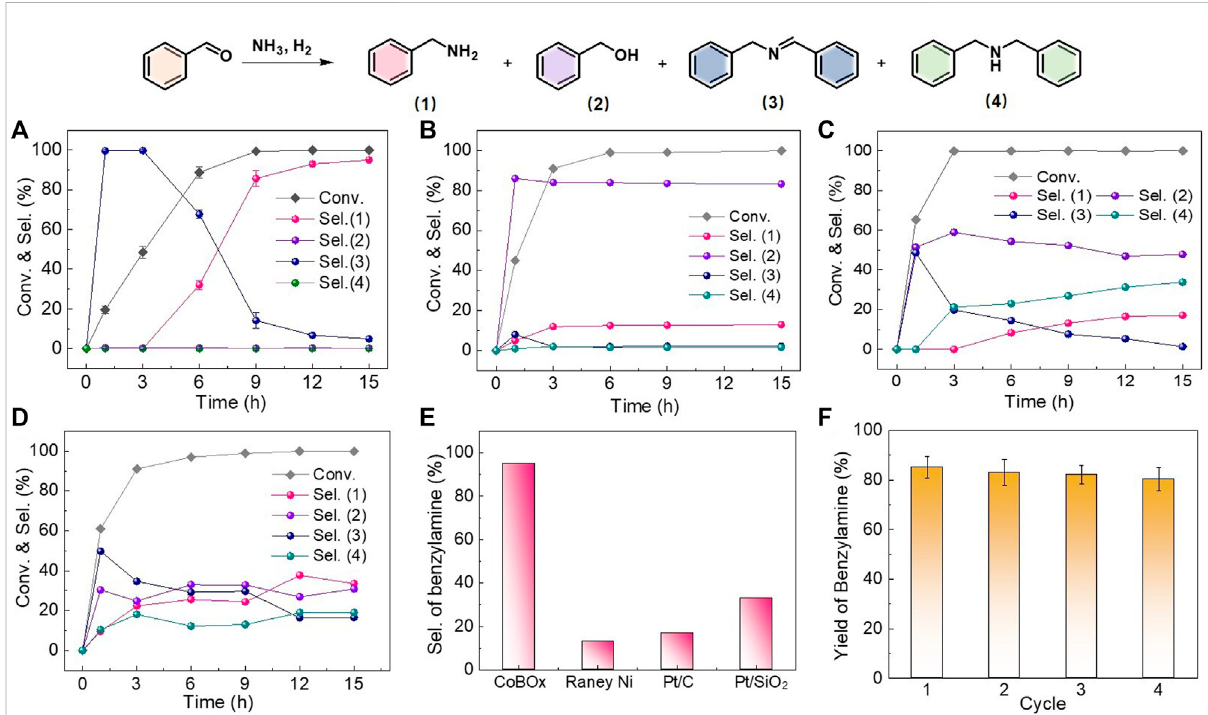
FIGURE 3 Catalyticperformanceof (A) CoBO x , (B) RaneyNi, (C) Pt/Cand (D) Pt/SiO 2 catalysts. (E) Comparisonontheselectivityofbenzylamineattheend ofthereaction. (F)